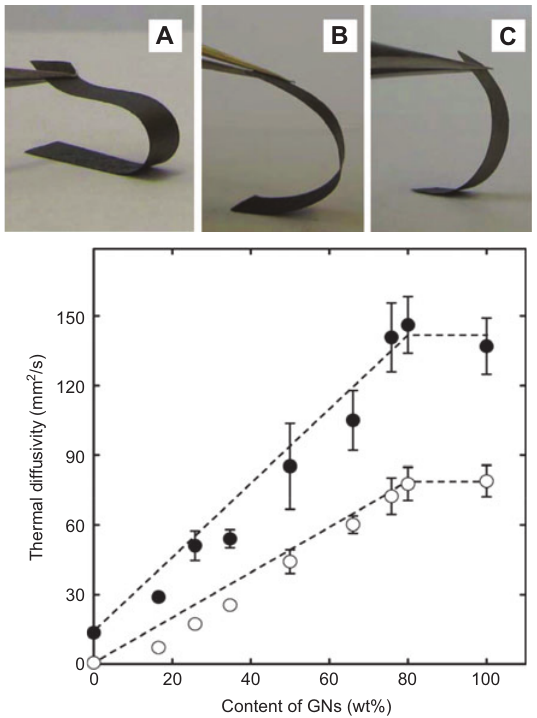
Figure 11 (Top) Photos of nanocomposite fi lms containing 50 % GNs (A) and 80 % GNs (B, as- fabricated; C, after the thermal anneal- ing). (Bottom) The observed in-plane thermal diffusivity as a func- tion of the GN loading in the nanocomposite fi lms as fabricated ( (cid:4) ) and after thermal annealing ( (cid:2) ), with the error bar denoting standard deviation for multiple data points. (Reproduced from Ref. [84] with permission from the American Chemical Society.)